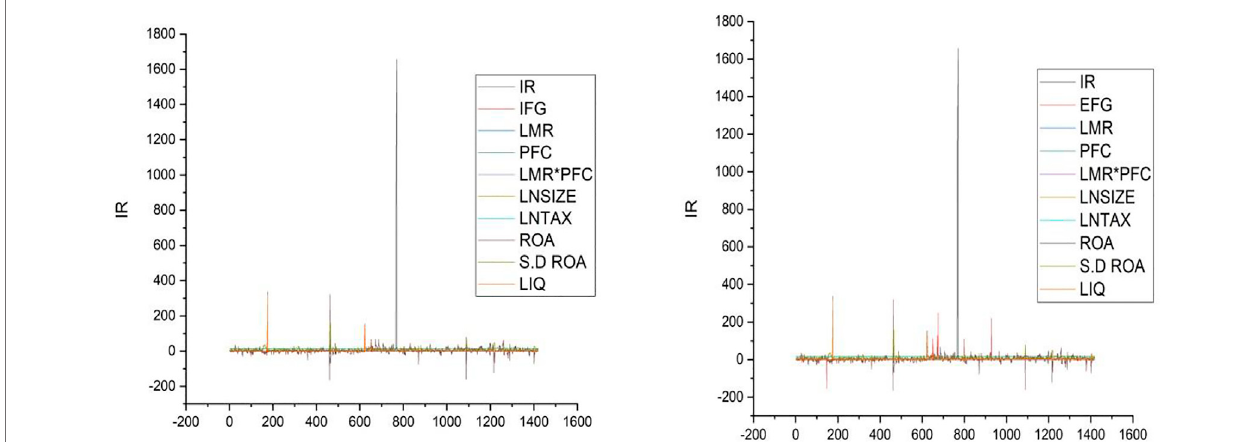
FIGURE 2 | Multiple regression graphs for IFG and EFG